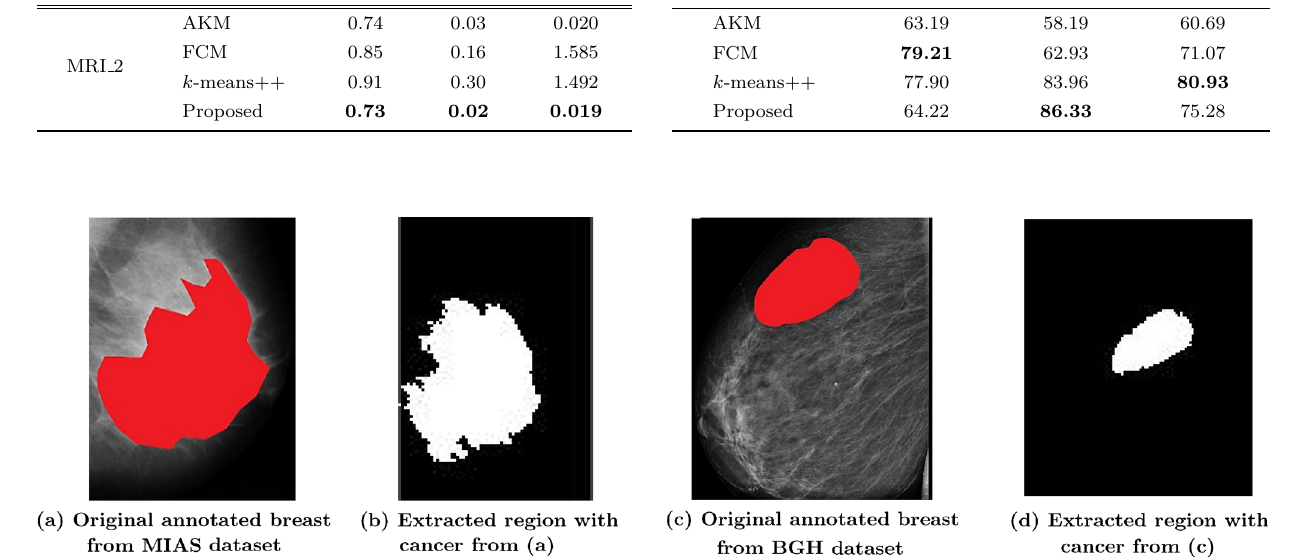
Fig. 8 Examples of annotated and extracted region with cancer for breast mammographic images from BGH and MIAS datasets using proposed